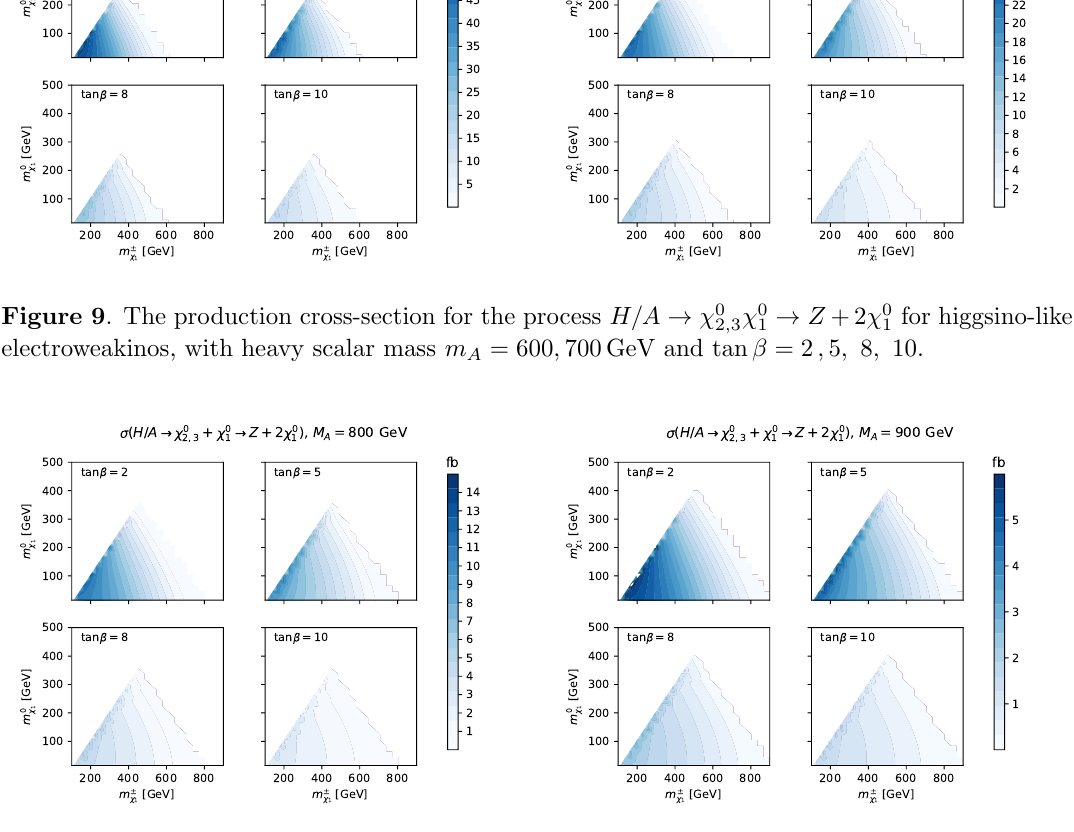
(cid:31) 0 (cid:31) 0 Z +2 (cid:31) 0 for higgsino-like 2 ; 3 1 ! 1 !